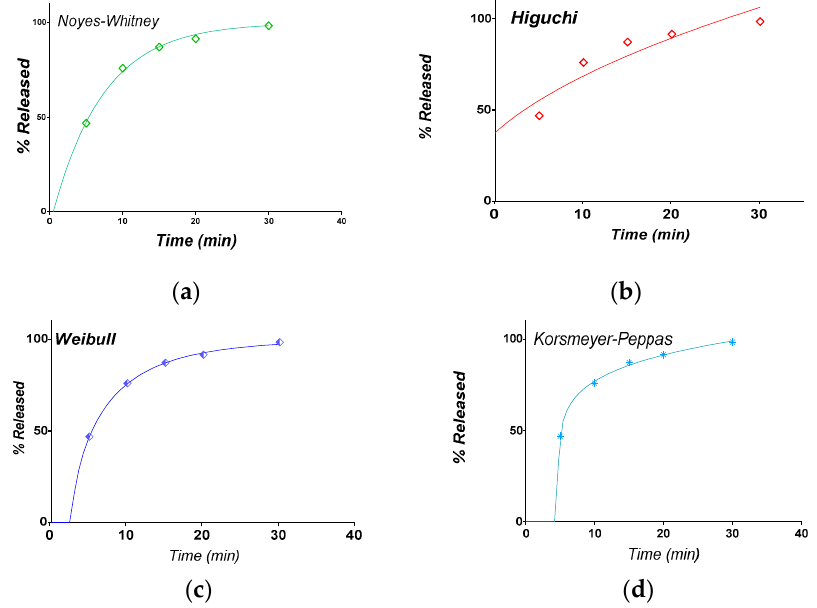
Figure 13. Fitting of the CAP release experimental profiles from orally disintegrating tablets containing the CAP- β -CD inclusion complex in simulated saliva, using various mathematical models: ( a ) Noyes-Whitney, ( b ) Higuchi, ( c ) Weibull and ( d ) Korsmeyer-Peppas. The parameters of each model, as well as the performance evaluation of the fittings, are shown in Table 2. Table 2. Evaluation of the performance of the captopril release profiles in simulated saliva (Pk-Solver). AIC: Akaike Information Criterion. Parameter